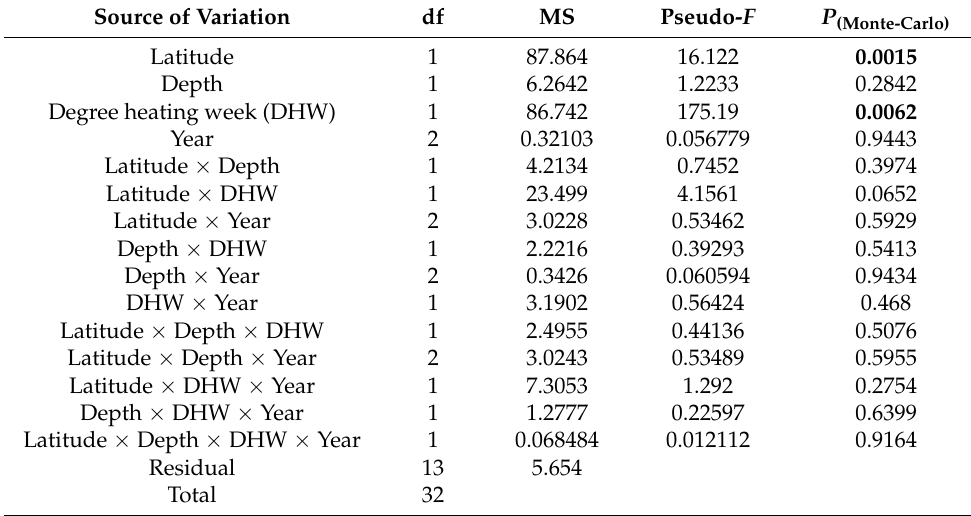
Figure 7. Bleaching index of coral communities from 13 sites in Maputaland surveyed in 2015, 2016, and 2017 in relation to ( a ) latitude (°S), ( b ) cumulative degree heating weeks (°C), ( c ) depth (m) and ( d ) site. * = no data. Table 2. Permutational analysis of covariance investigating variation in bleaching index according to latitude, depth, cumulative daily degree heating week (DHW) and year on reefs in the south-west Indian Ocean from 2015–2017. Significant effects are indicated in bold ( α =